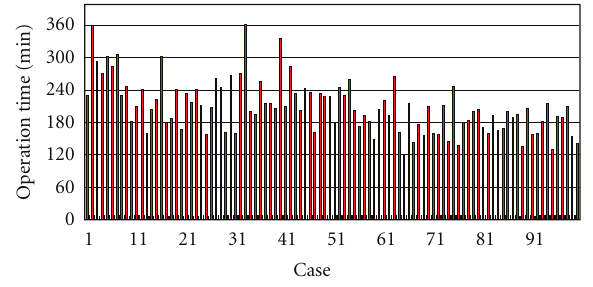
Figure 1: Operation time for all patients.